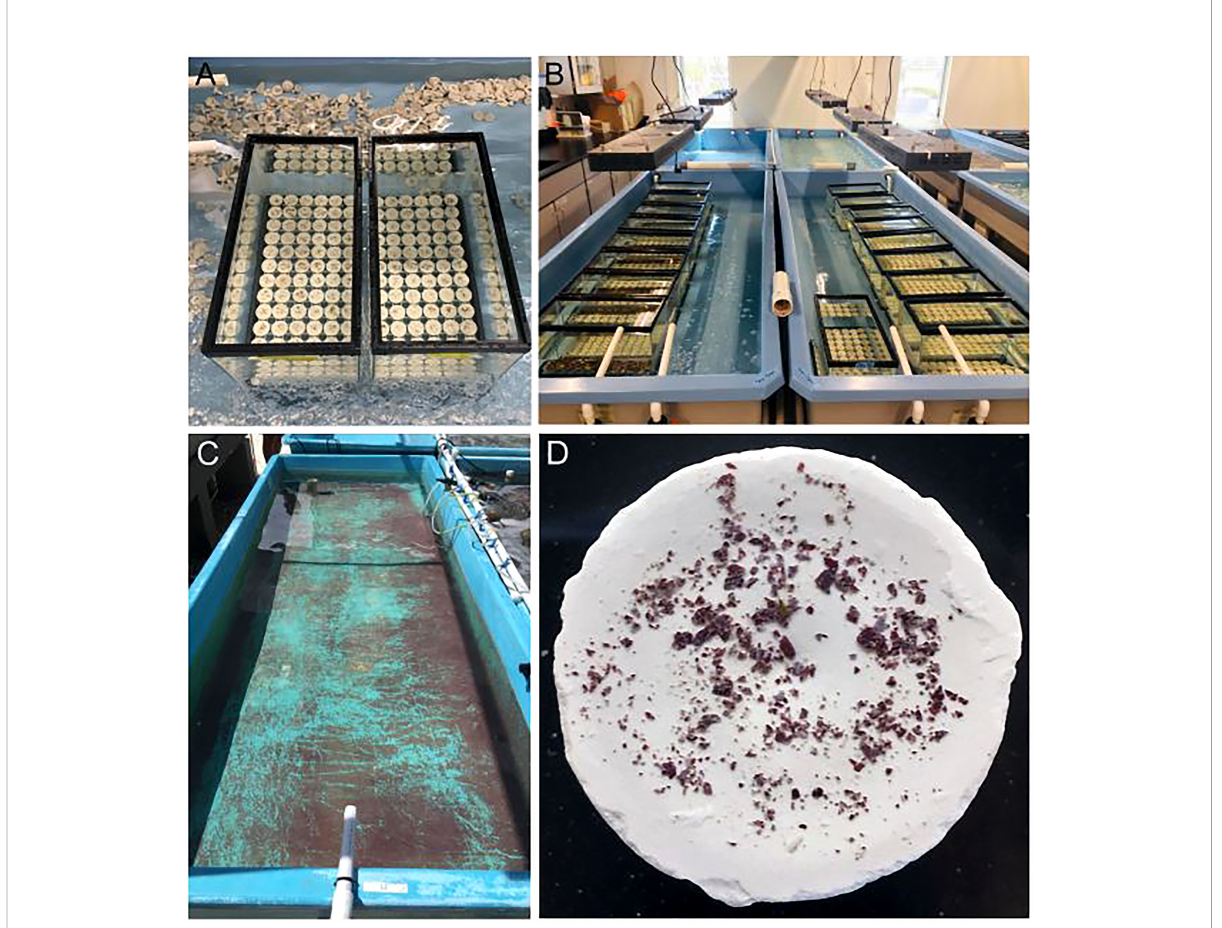
FIGURE 2 Coral larval settlement in closed containers. (A) 4 L glass tanks used for settlement. (B) Settlement tanks are held within partially fi lled raceways for temperature stability. (C) Naturally occurring crustose coralline algae (CCA) is cultivated within a raceway for using as a settlement cue. (D) Freshly harvested CCA fl akes are sprinkled onto a settlement substrate (ceramic plug) to provide chemical cues to larvae. Source: Hanna